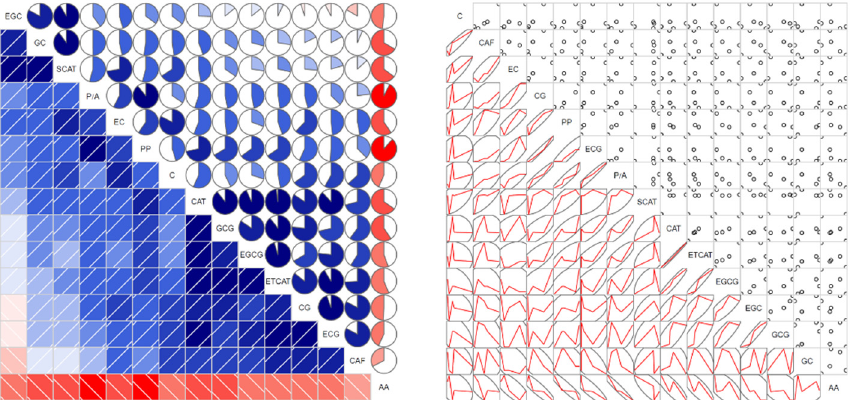
Figure 4. Correlogram of CAT, AA, PP, CAF, EC, GC, EGC, CG, ECG, GCG, EGCG, C, SCAT and ETCAT. Left : Correlations of three different colored-leaf tea types. Red refers to a negative correlation, blue refers to a positive correlation, and the shade of color is proportional to the strength of the correlation. Right : Correlations of purple-red tea types. Lines indicate trends in correlations.